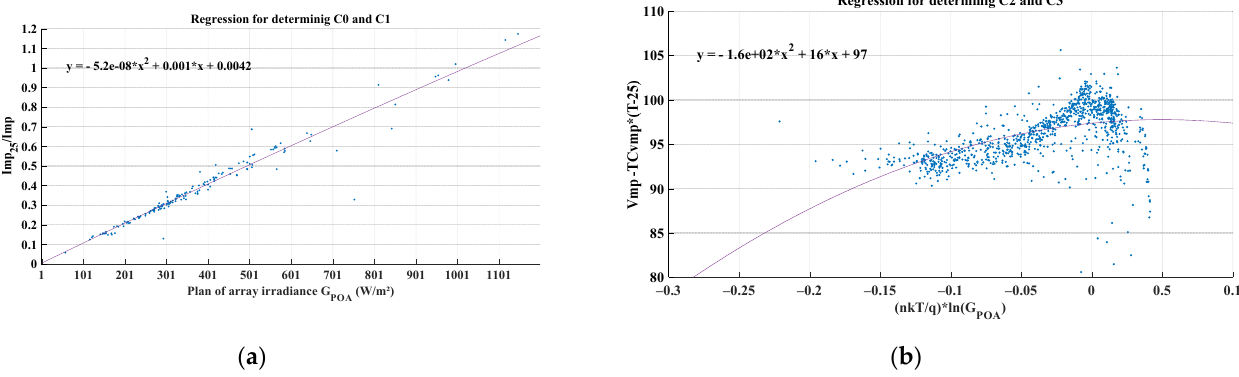
Figure 3. Regression for determining the coefficients of the empirical model, C0 and C1 coefficients relate Impx to the G POA ; C2 and C3 coefficients relate Vmpx to the G POA . ( a ) Regression of equation (7), C0 = 0.001 and C1 = − 5.2 × 10 − 9 . ( b ) Regression of equation (8), C2 = 0.1 and C3 = − 0.89.